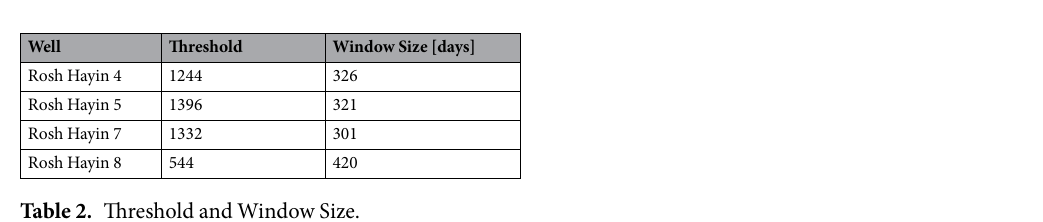
Table 2. Threshold and Window